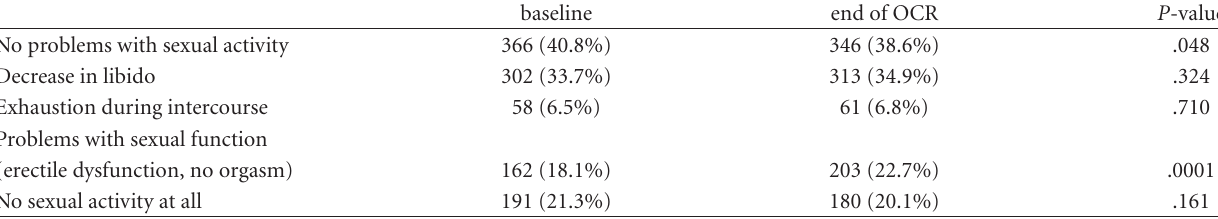
(a) Sexual activity and dysfunction in males as reported in questionnaires ( n =